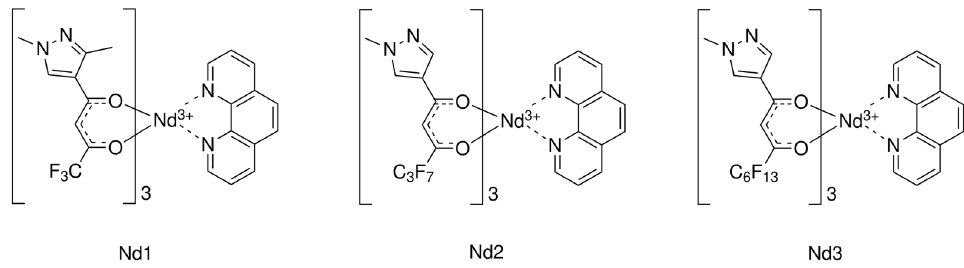
Figure 1. The 1,3-diketonate coordination compounds of Nd 3+ synthesized.